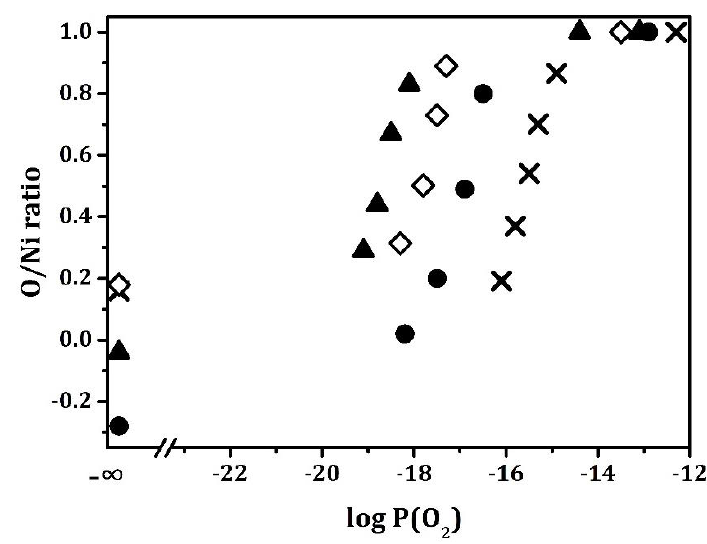
Figure 5. Oxidation isotherm obtained using coulometric titration at 1073 K for (×) Ni/MgAl 2 O 4 ; ( ▲ ) Ni/CaTiO 3 /MgAl 2 O 4 ; (◊) Ni/SrTiO 3 /MgAl 2 O 4 ; and, (●) Ni/BaTiO 3 /MgAl 2 O 4 .